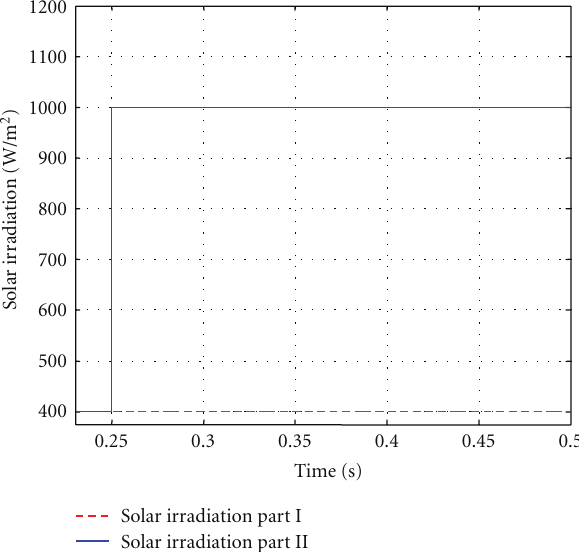
Figure 24: Partial change of solar irradiation 400W/m 2 to 1000 W/m 2 .